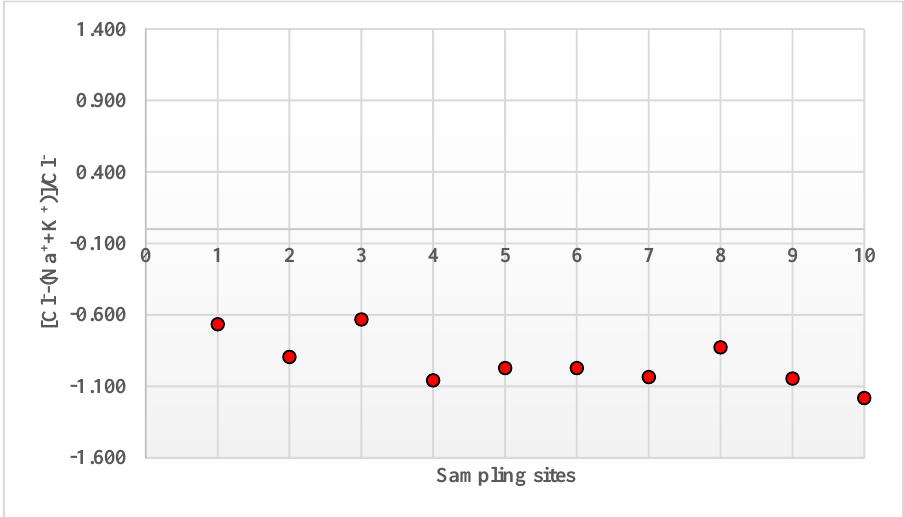
Figure 12. Chloro Alkaline Index type 1 (CAI 1) to determine the type of ion exchange occurred in the studied area.